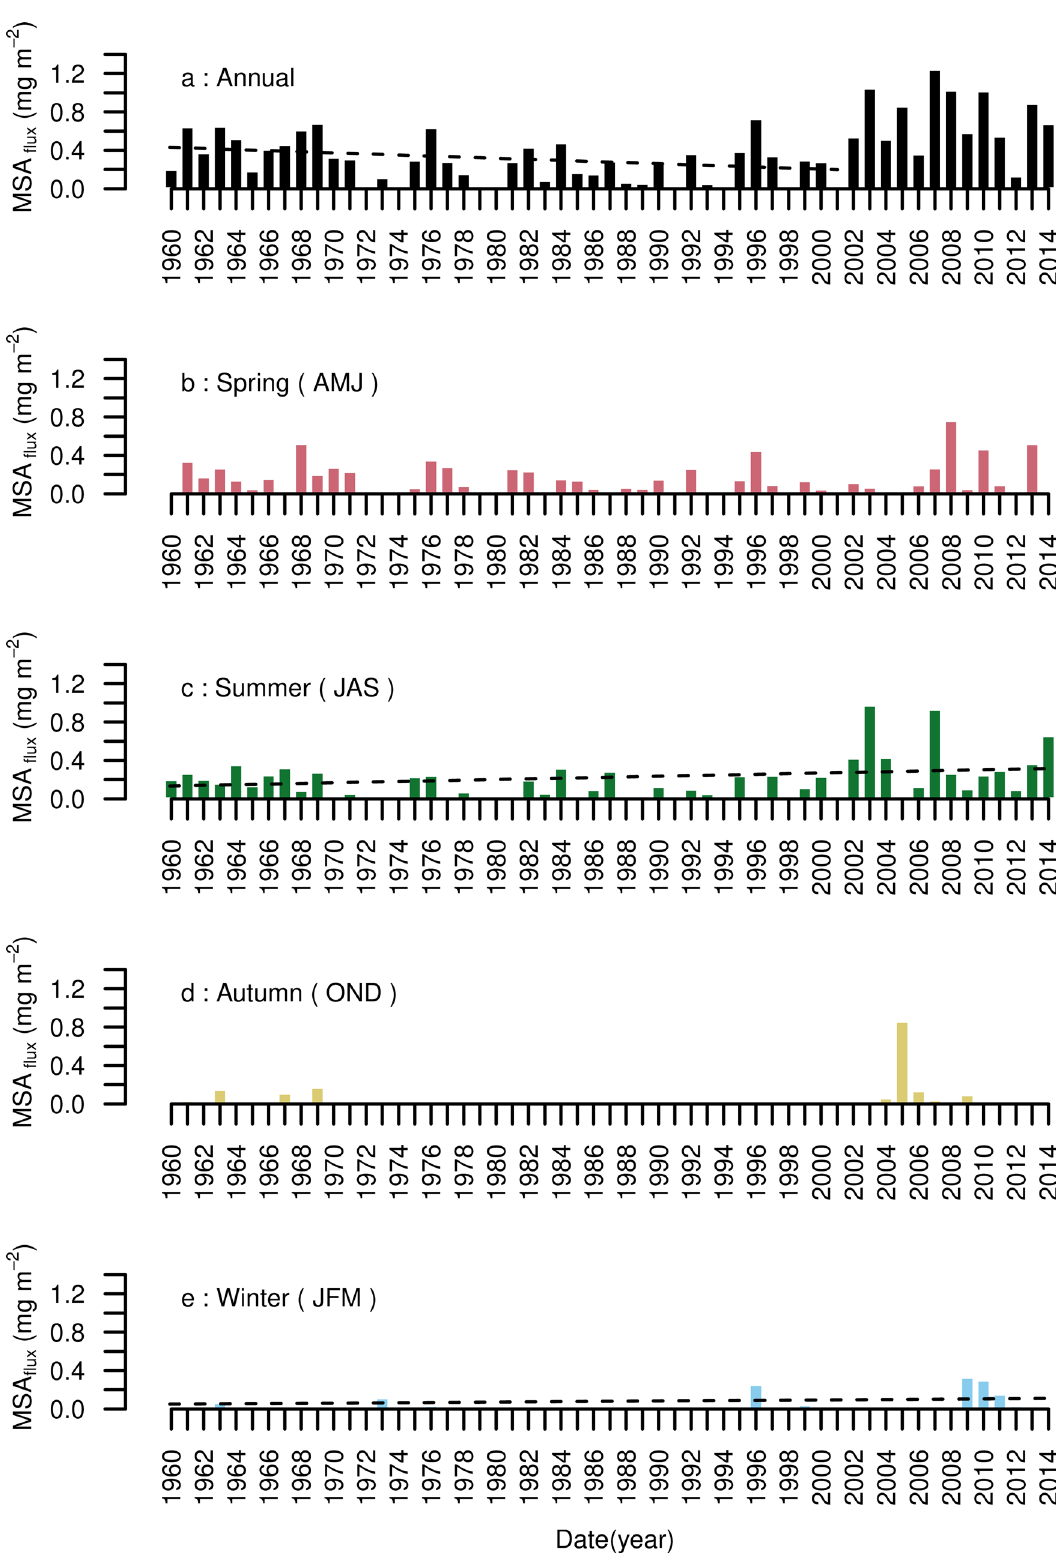
COMMUNICATIONS EARTH & ENVIRONMENT| (2022) 3:327 |https://doi.org/10.1038/s43247-022-00661-w|www.nature.com/commsenv